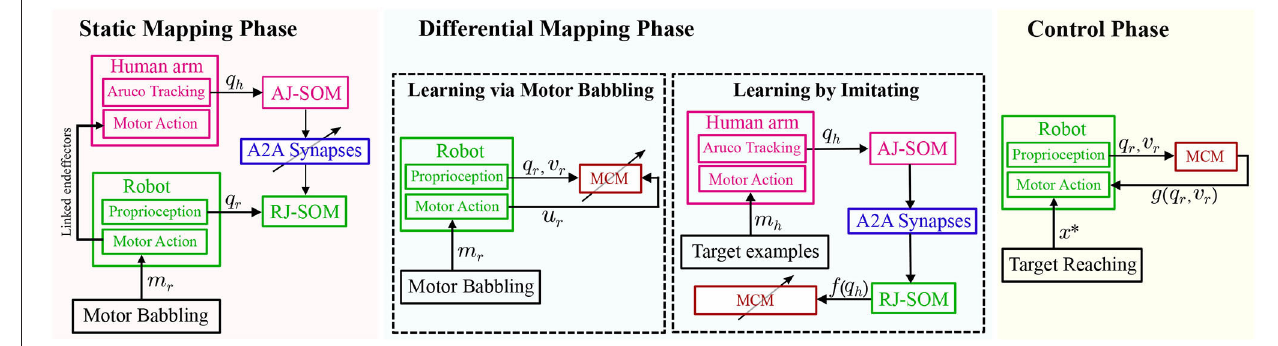
FIGURE 7 | A schematic diagram of the full system including both the static (SOMs network) and differential(MCM network) maps formed. Blocks with an inclined arrow passing through are the ones where learning/adaptation occurs during each phase.